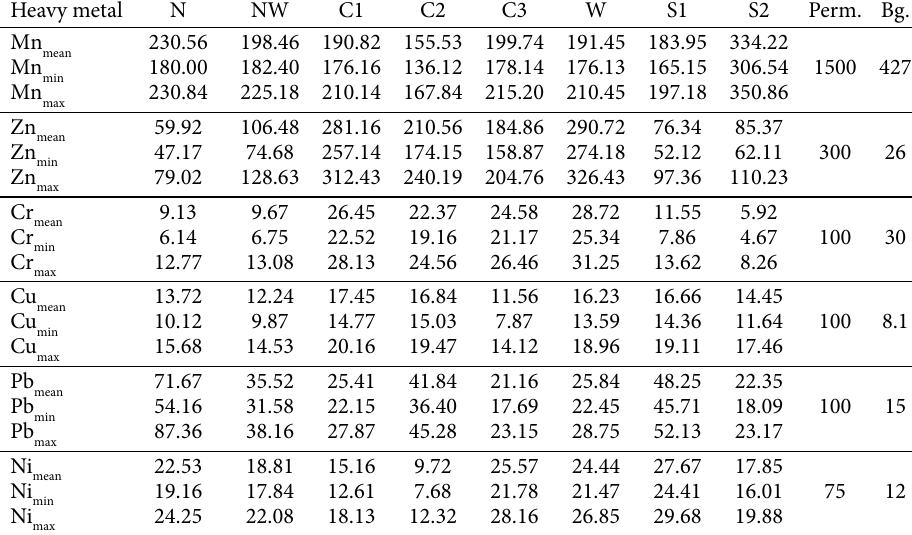
table 1. Heavy metal (mg/kg) distribution among the investigated area (Perm. – permitted concentra- tion mg/kg, Bg. – background concentration mg/kg of sand and sandy loam soils) Heavy metal n